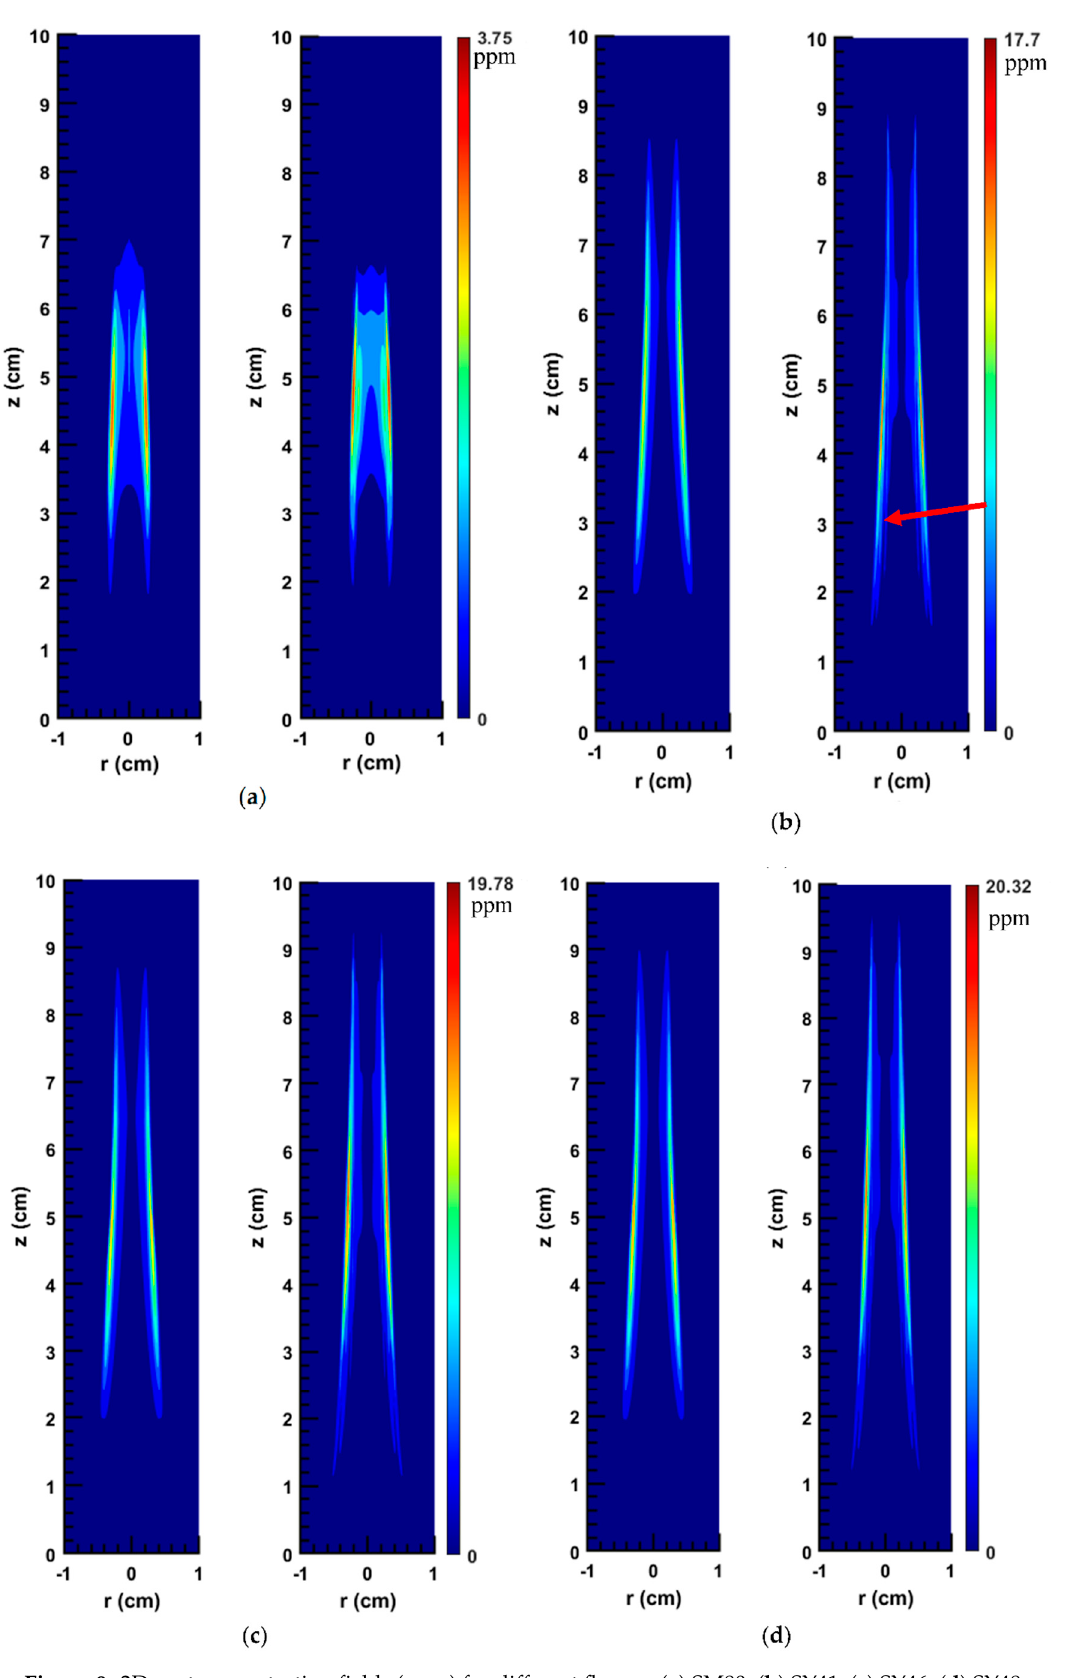
Figure 9. 2D soot concentration fields (ppm) for different flames: ( a ) SM80; ( b ) SY41; ( c ) SY46; ( d ) SY48; as obtained by two methods, using the original numerical solution (left image in each pair) and using the ANN prediction (right image in each pair).